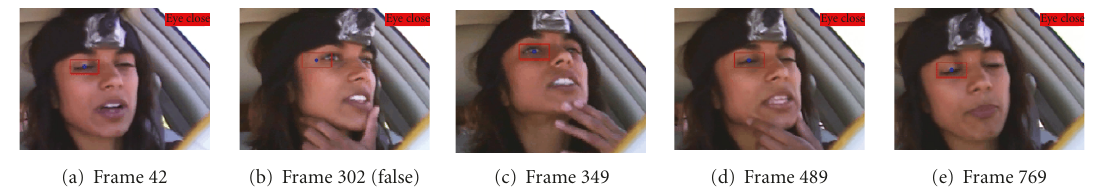
Figure 5: Examples of the blink detection results for in-car videos. Red boxes are tracked eyes, and the blue dots are the center of the eye locations. The red bar on the top-left indicates the presence of closed